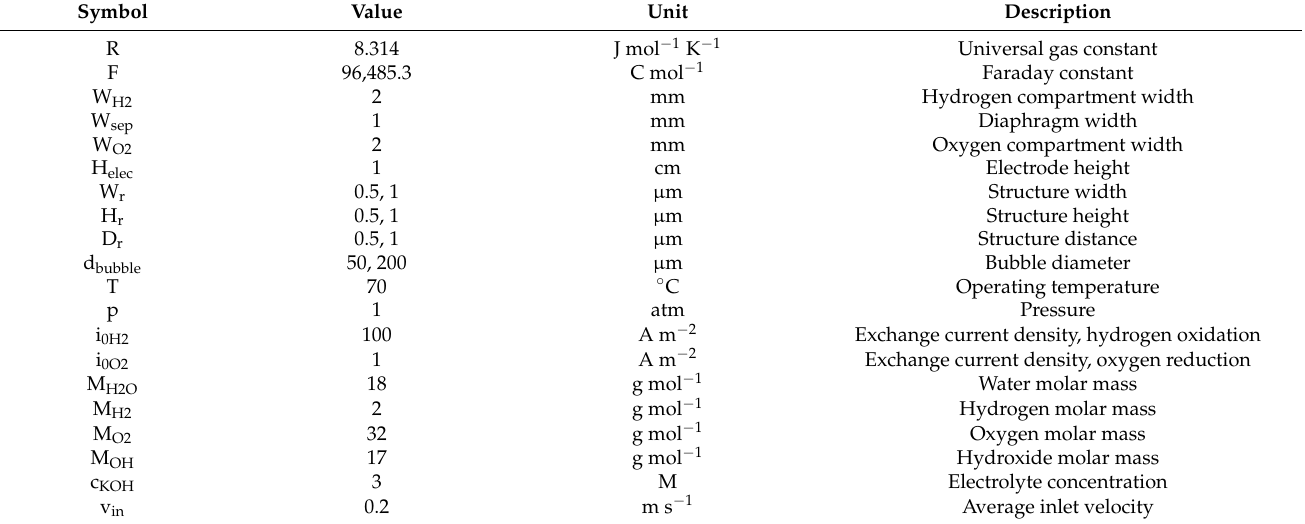
Table 1. Initial values of the 2D AWE